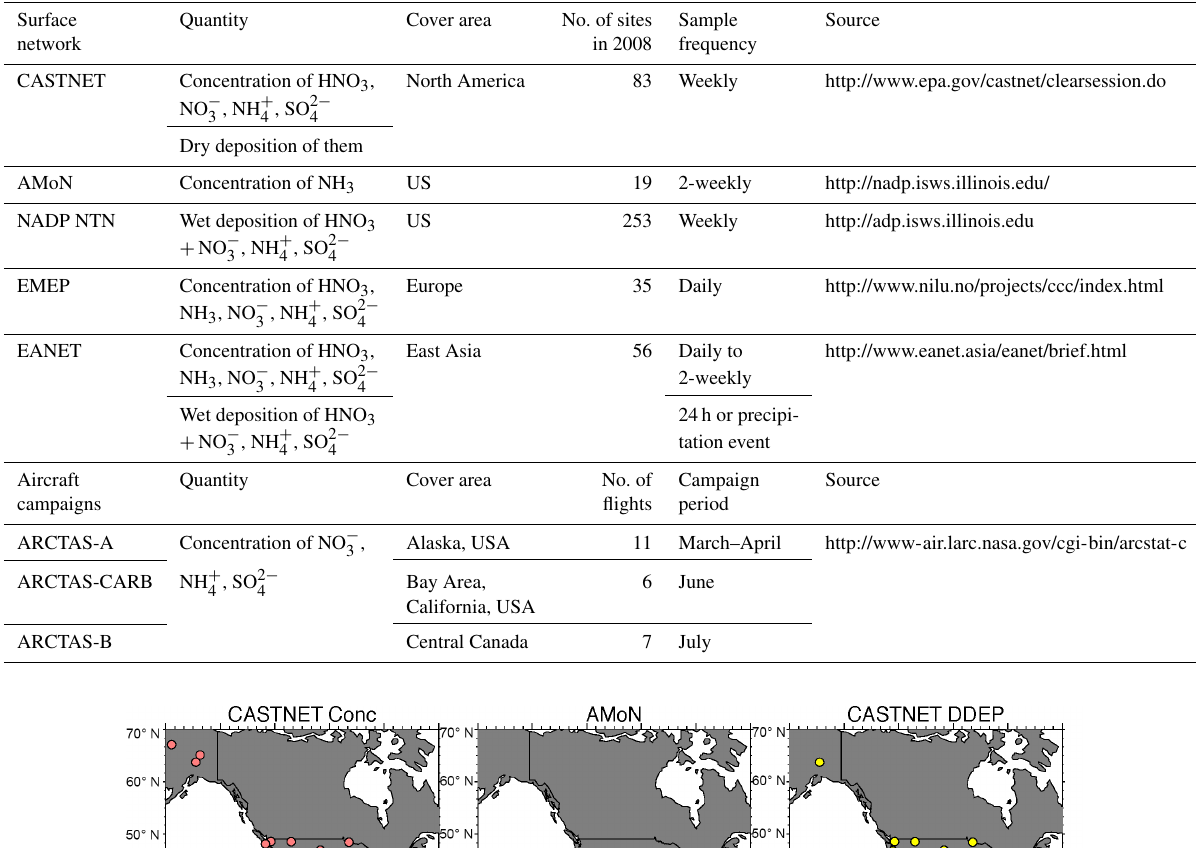
Table 3. Summary of the observational data used in this study.